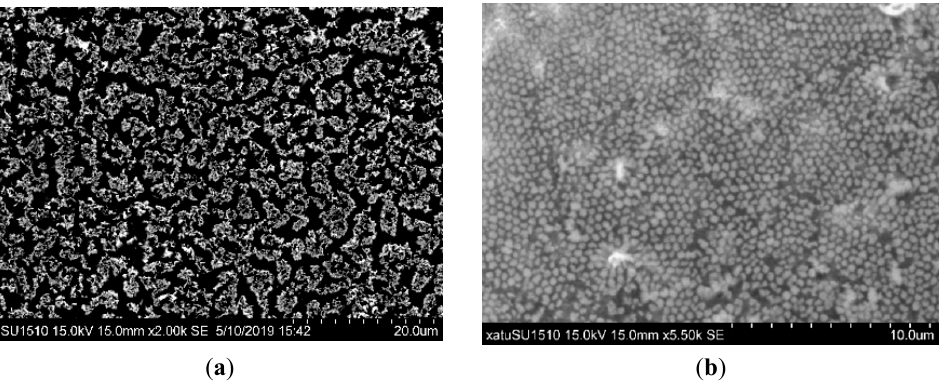
Figure 3. Comparison of top views of SiNWs fabricated by two methods: ( a ) SiNWs fabricated with the randomly distributed Ag fi lm; ( b ) SiNWs fabricated with the spatially ordered mesh Au fi lm.